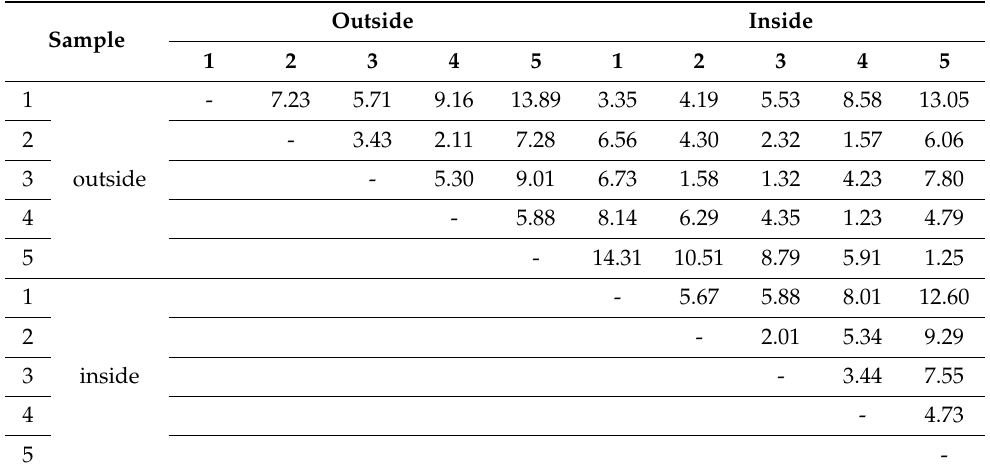
Table 3. The color differences of butter samples.